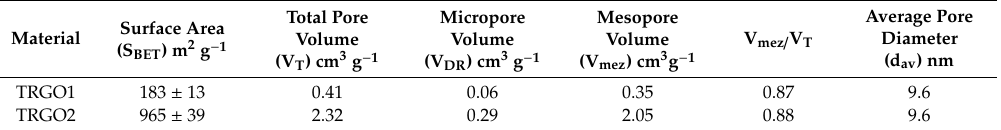
Figure 3. Isotherms of adsorption and desorption of N 2 at 77 K (for Materials 1 and 2). Table 2. The parameters of the porous structure of graphene oxides obtained using Methods 1 and 2.